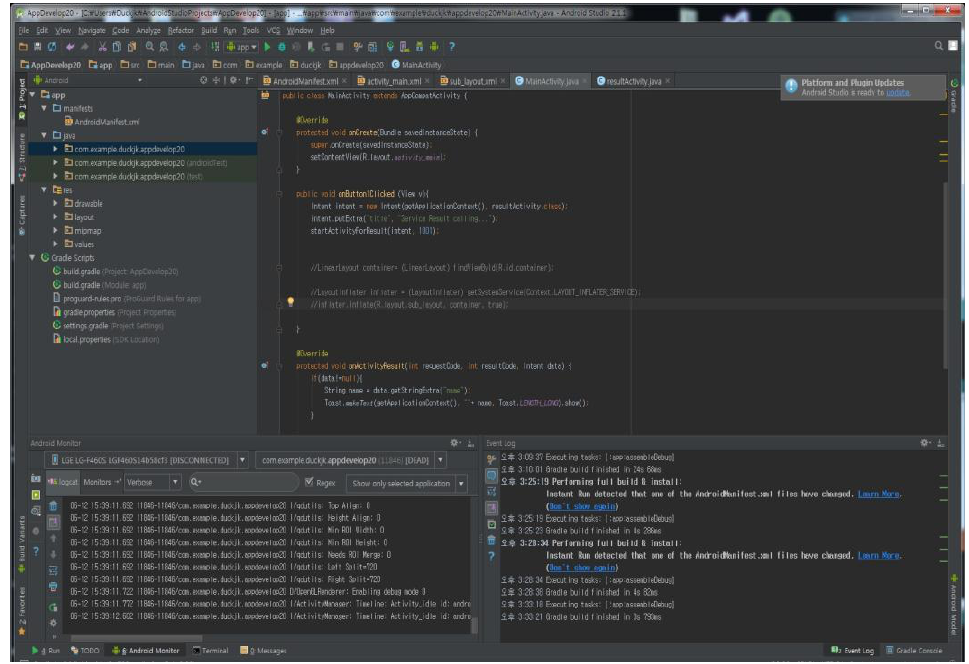
Figure 15. Coding screen provide the service after analyzing the sensed values in Arduino.